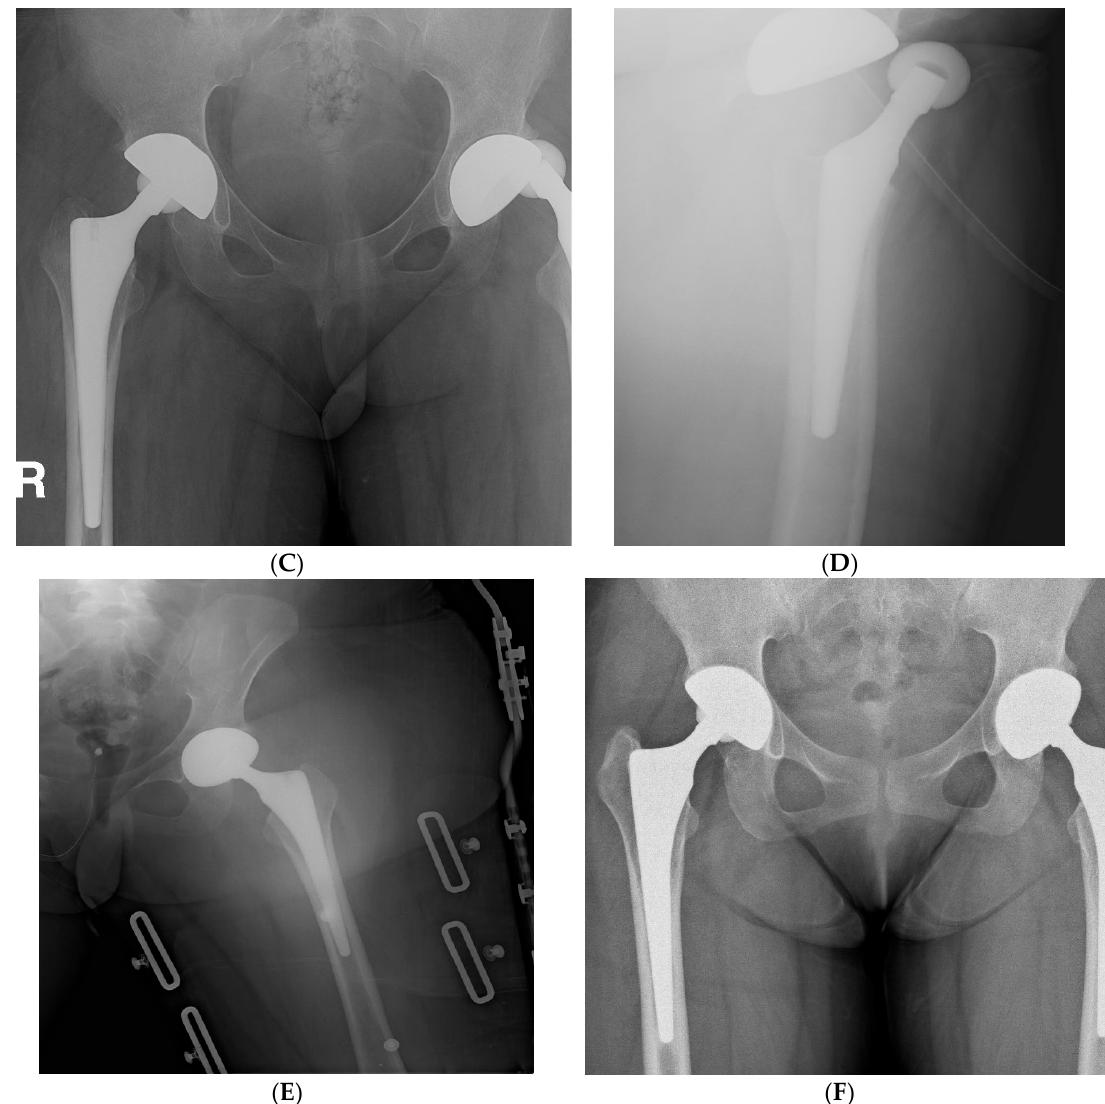
Figure 2. ( A , B ) Preoperative and postoperative hip radiographs of a 33-year-old woman with cognitive dysfunction and visual disturbance after removal of recurrent craniopharyngioma. She underwent simultaneous bilateral THA due to ONFH. ( C , D ) Radiographs of the same woman on the 15th postoperative day, when she visited the emergency department due to severe pain in the left hip. Anteroposterior and lateral images demonstrated anterior hip dislocation. ( E ) Hip radiograph after performing closed reduction followed by abduction brace application under general anesthesia. ( F ) Eight-year postoperative radiograph showed stable implant fixations.